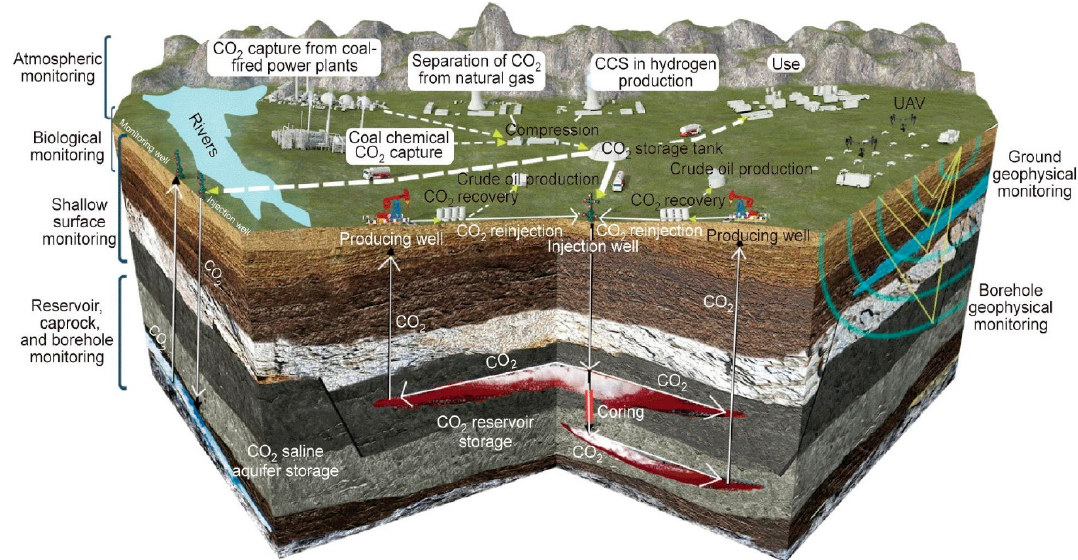
Figure 1. The CCS industry chain [2].